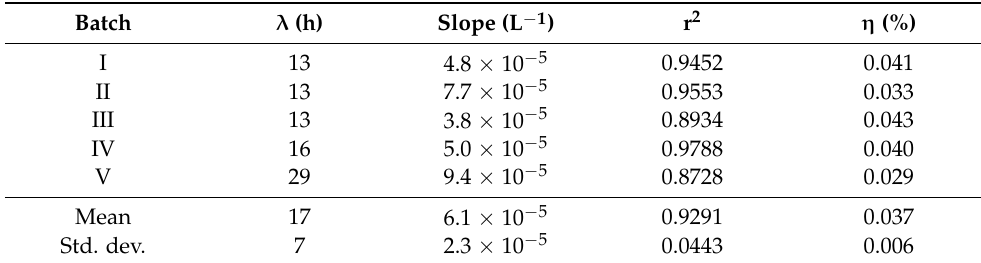
Table 1. Summary of the lag time estimated directly from the pH curve, and of the efficiency determined from the linear fit of f H vs. H plots.